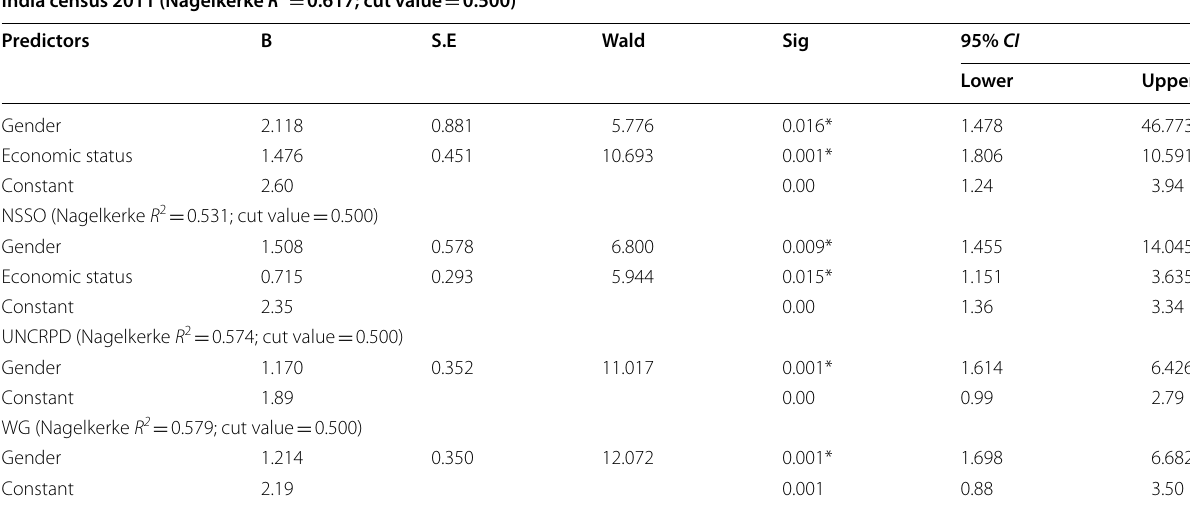
NSSO , National Sample Survey Organization; UNCRPD , United Nations Convention on the Rights of the Persons with Disabilities; WG , Washington group. *Multivariate logistic regression analysis found that female gender and lower socio-economic status were independent influencing factors of the prevalence of disability, and the difference was statistically significant ( P <